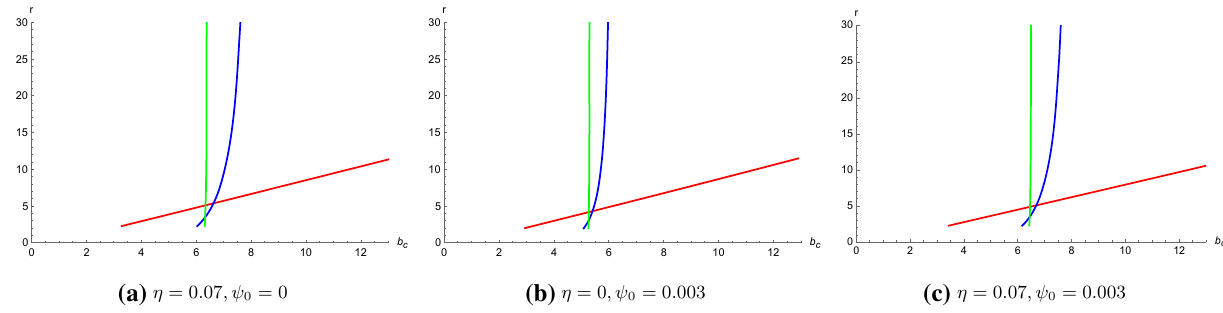
Fig. 4 The first three transfer functions for the f ( R ) global monopole black hole